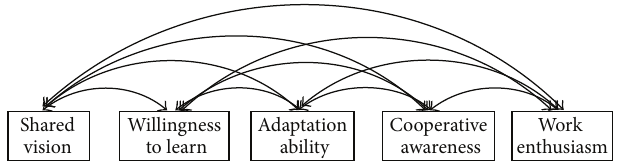
Figure 2: The hypothesized model of organizational resilience.